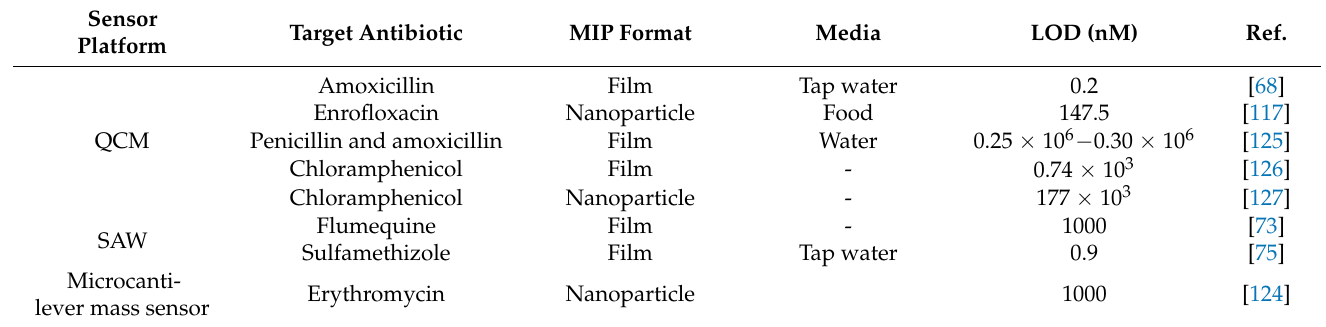
Table 3. Antibiotic MIPs combined with piezoelectric label-free sensor platforms and their